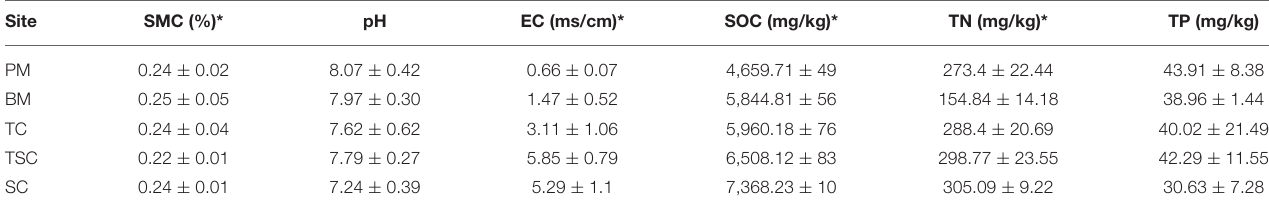
TABLE 1 | The heterogeneous soil properties in the tidal creek salt